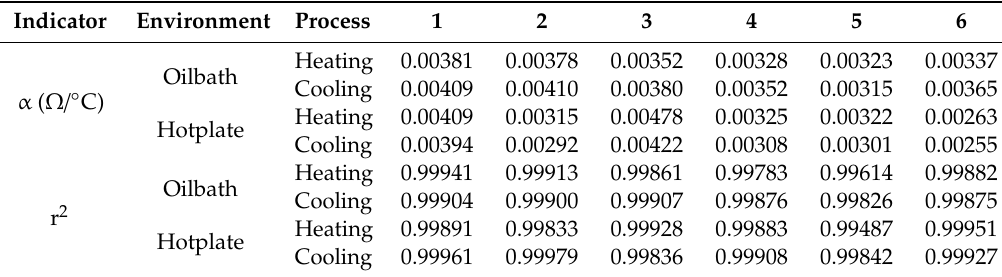
Figure 6. Temperature-sensitive performance of all the samples. ( a – d ) Resistance-temperature curves of all the samples from No.1 to No.6 in the conditions of oil bath ( a , b ) and hotplate stages ( c , d ). Table 2. TCR and correlation coefficients of all the samples.